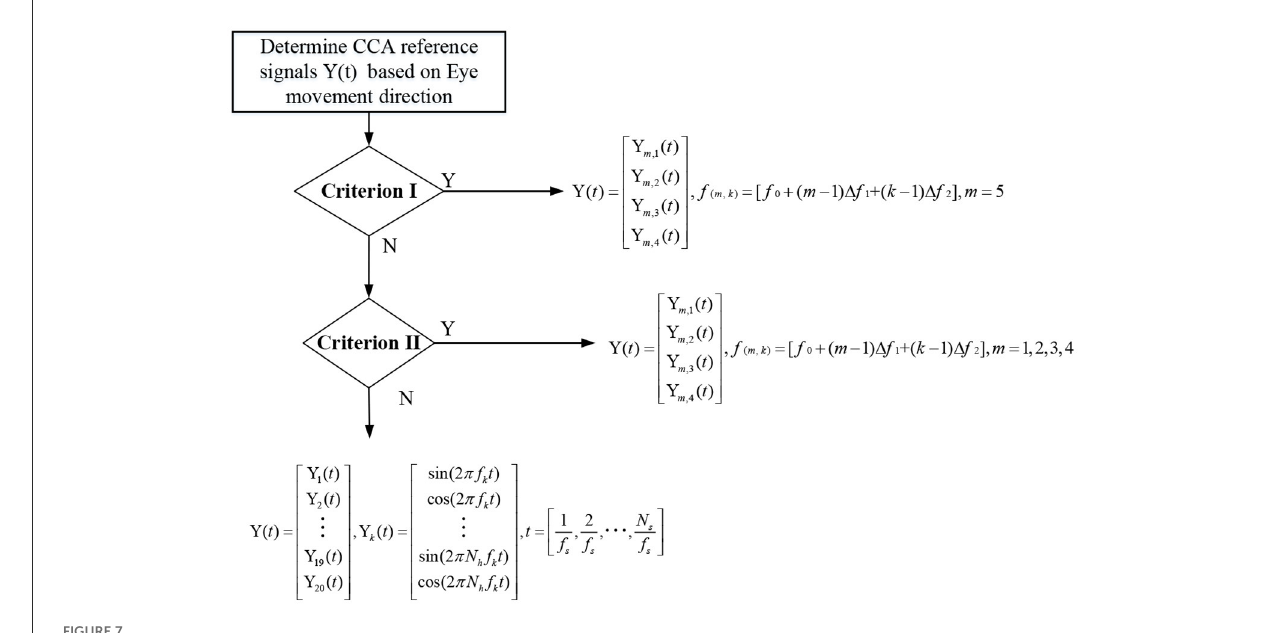
FIGURE7 Flow chart of decision-making methods.